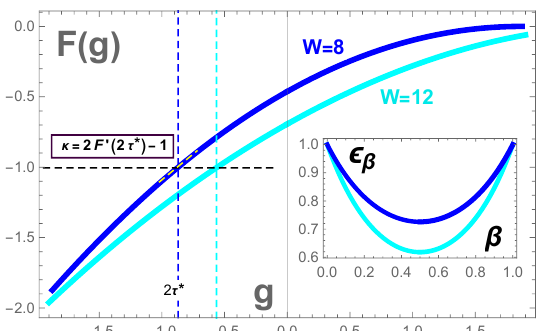
Figure 12: (Color online) The functions ε β and F ( g ) and the theoretical value of κ . The eigenvalue ε β of the transfer-matrix equation on a tree with the modi- theor fied on-site energy distribution is found from the numerical solution of a non-linear problem [ 58, 65 ] for K = 2 Cayley tree for the box-shaped initial disorder distribu- tion with W = 8 (dark blue) and W = 12 (light blue). The corresponding function F ( g ) in the distribution, Eq. (3), is computed from Eq. (73). The “theoretical” value of the stretch-exponent κ is found from Eqs. (36) and (39) and is determined by theor the derivative F (cid:48) ( g ) at a point where F ( g ) = − 1.